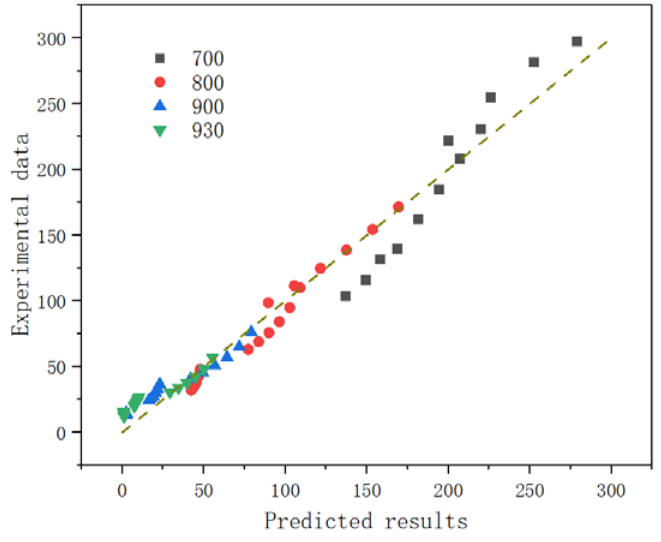
Figure 13. Comparison between the experimental data and the predicted stresses from the constitutive model with strain